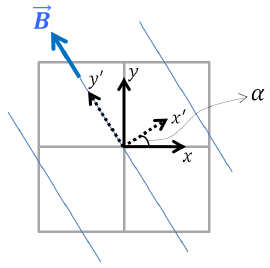
Figure 2. Regular structured mesh with tilted Magnetic field. Blue lines are aligned with the magnetic field (cid:126) B . The variables x and y are the Cartesian coordinates (reference) and x (cid:48) and y (cid:48) are the coordinates aligned with the magnetic